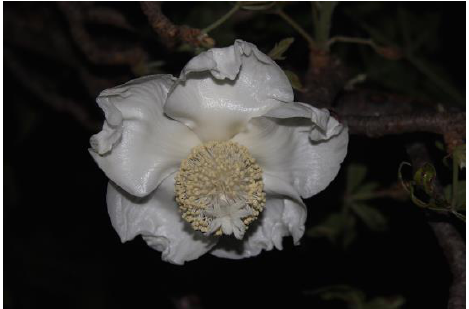
night while the bud on the left should remain closed. Photo © Sarah Venter.